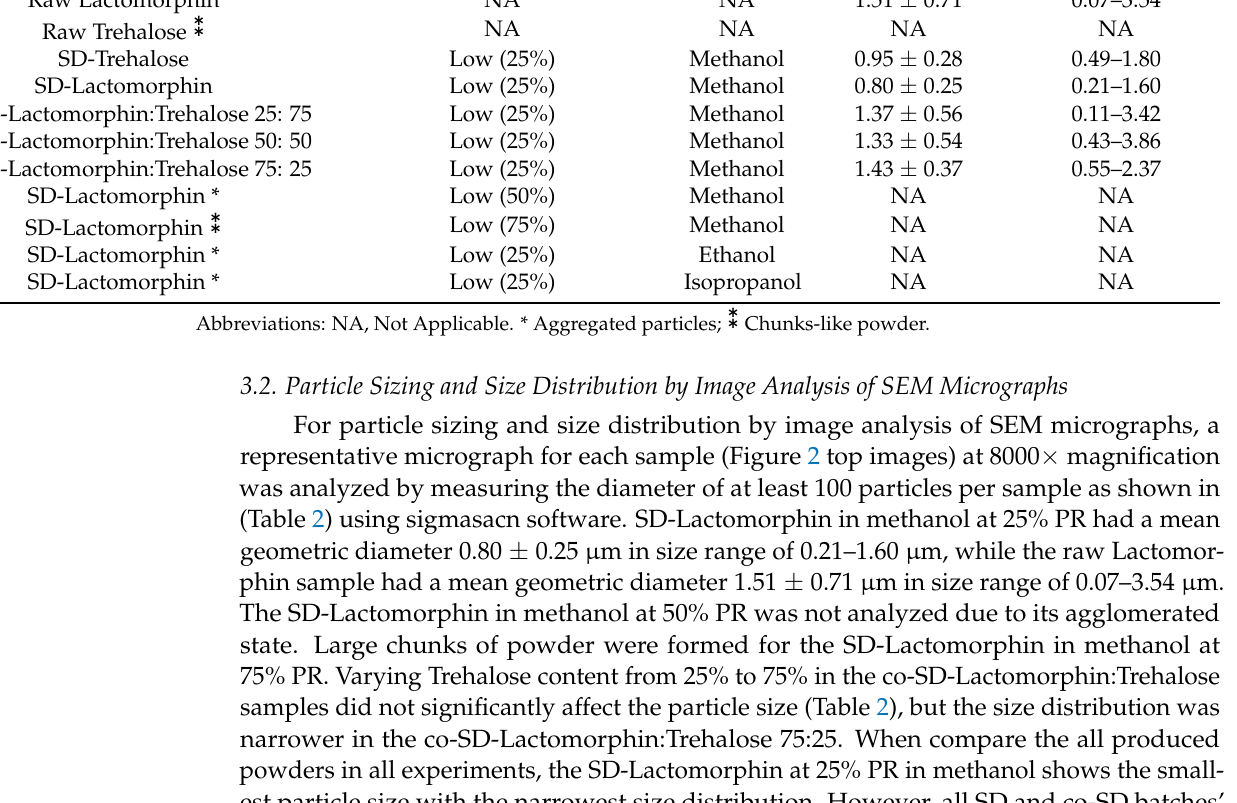
Table 2. Particle sizing using image analysis on SEM micrographs ( n ≥ 100 particles).